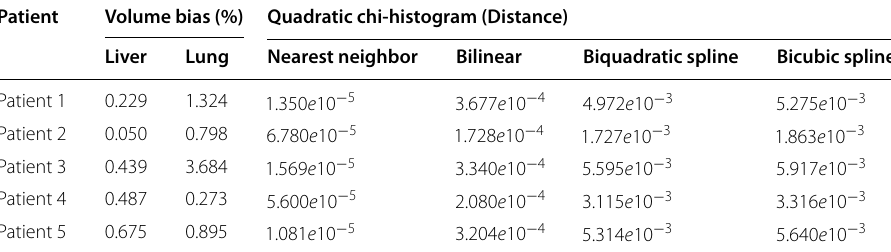
Table 2 Preprocessing biases between the nominal and CT image inputs are summarized for organ volume calculations and interpolation methodologies